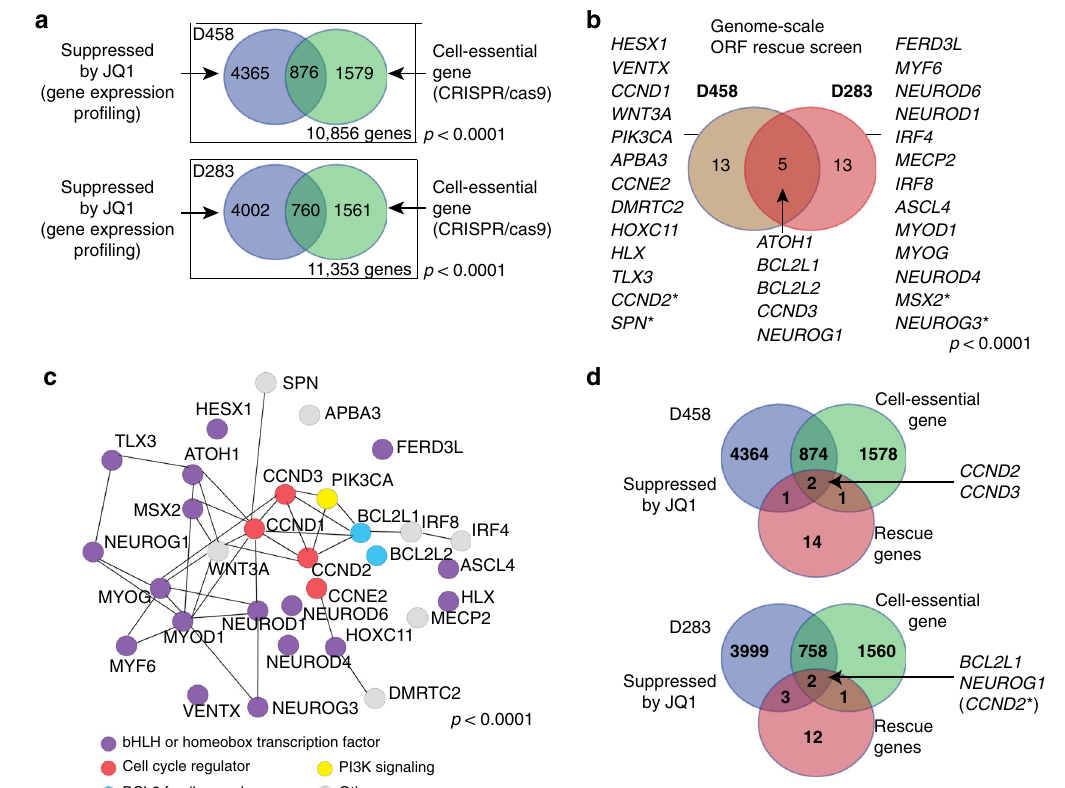
Fig. 2 Rescue genes are enriched for cell-cycle regulators and bHLH/homeobox transcription factors. a Intersection of genes suppressed by 1 μ M JQ1 with those identi fi ed to be cell essential (green) in D458 (top) and D283 (bottom). p -values indicate signi fi cance of overlap as determined with a Chi Square test. Source data: Supplementary Data Files 1 and 2. b Rescue genes identi fi ed in D458 (left) and D283 (right) cell lines following treatment with either JQ1 or IBET151. Asterisks indicate genes that scored as statistically signi fi cant rescue genes in both cell lines, but only met fold-change thresholds in the cell line shown. p -value indicates signi fi cance of overlap as determined by Fisher ’ s Exact Test. Source Data: Supplementary Data File 4. c STRING 59 protein network analysis to identify direct and functional protein networks that exist between the entire set of candidate rescue ORFs identi fi ed across both cell lines. Protein-protein interactions (edges) between ORF rescue genes (nodes) that scored in either D458 of D283 following treatment with JQ1 or IBET151 are shown. p value indicates signi fi cance of enrichment of protein-protein interactions. Source Data: Supplementary Data File 4. d Venn diagram depicting overlap of genes that are suppressed by JQ1 (blue), score as dependencies in CRISPR-Cas9 screens (green) and are identi fi ed to be rescue genes (red) in D458 (top) or D283 (bottom). *CCND2 met both the q value threshold and the log-fold change threshold in D458, but only the q -value threshold in